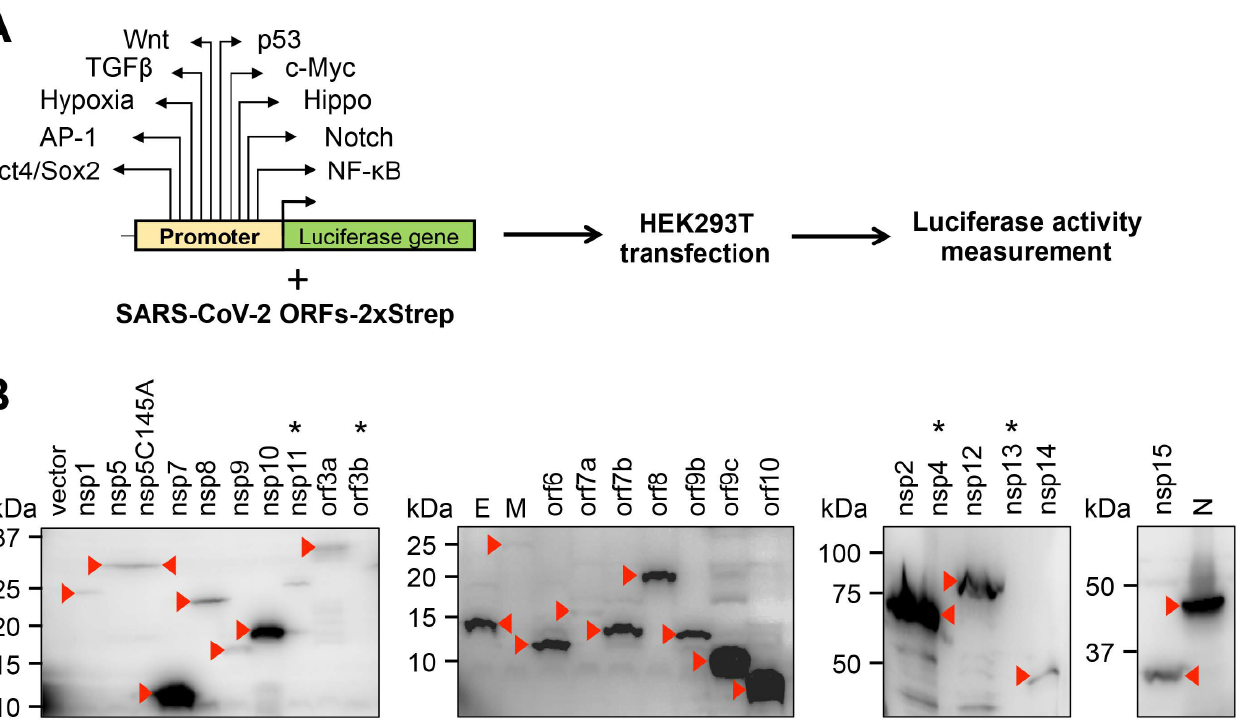
Figure 1. Experimental workflow for the study. ( A ) Outlining the signaling pathway luciferase reporter screen. The names of signaling pathways tested in this study are shown. ( B ) Immunoblot analysis of the expression of C-terminally 2xStrep-tagged SARS-CoV-2 proteins in transfected 293T cells using Strep-tag antibody. The red arrowheads indicate the viral proteins on the immunoblots. Viral proteins that are not expressed are indicated by an asterisk.